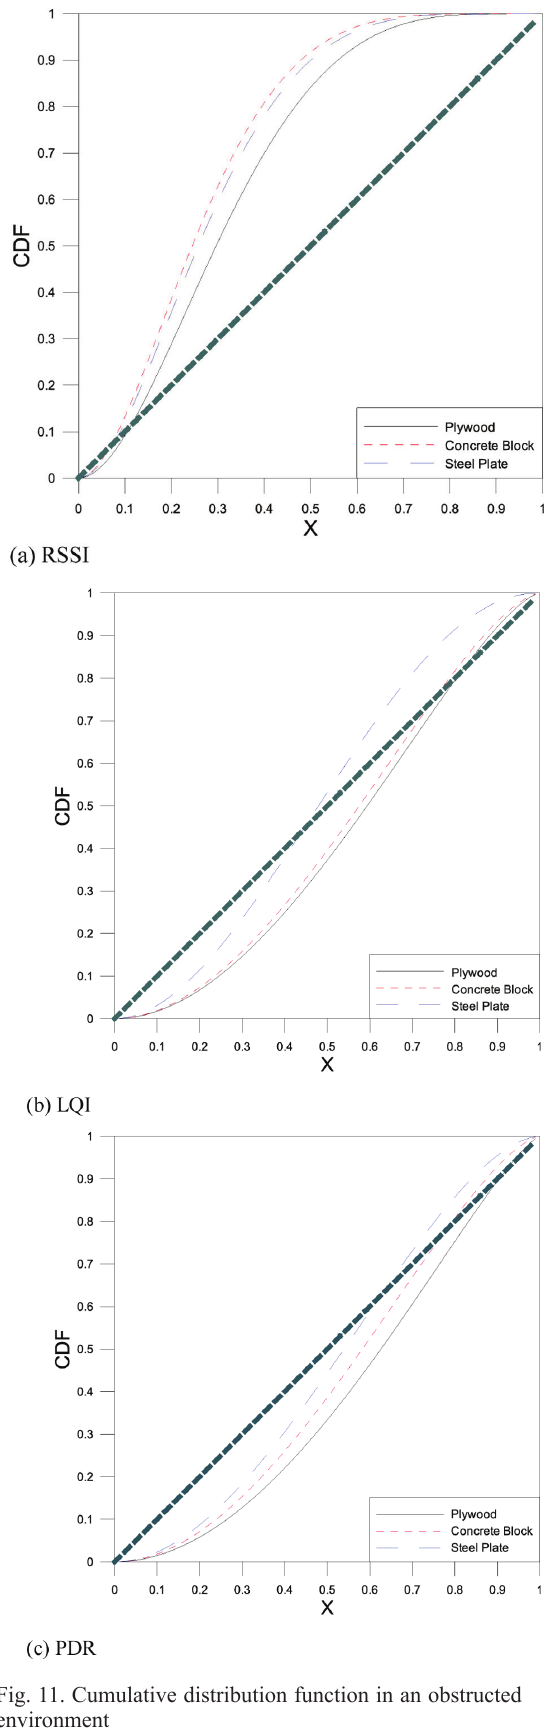
Fig. 11. Cumulative distribution function in an obstructed